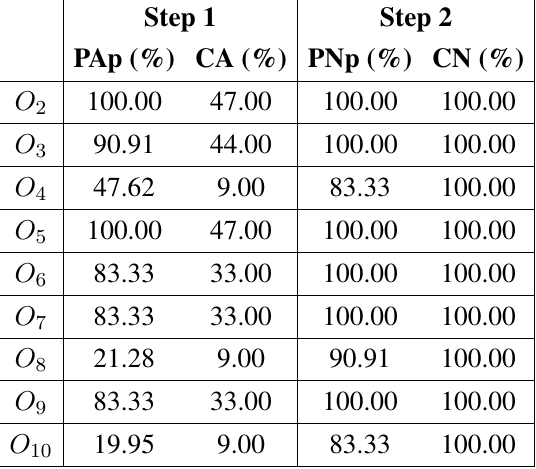
Table 5. Obtained results from the